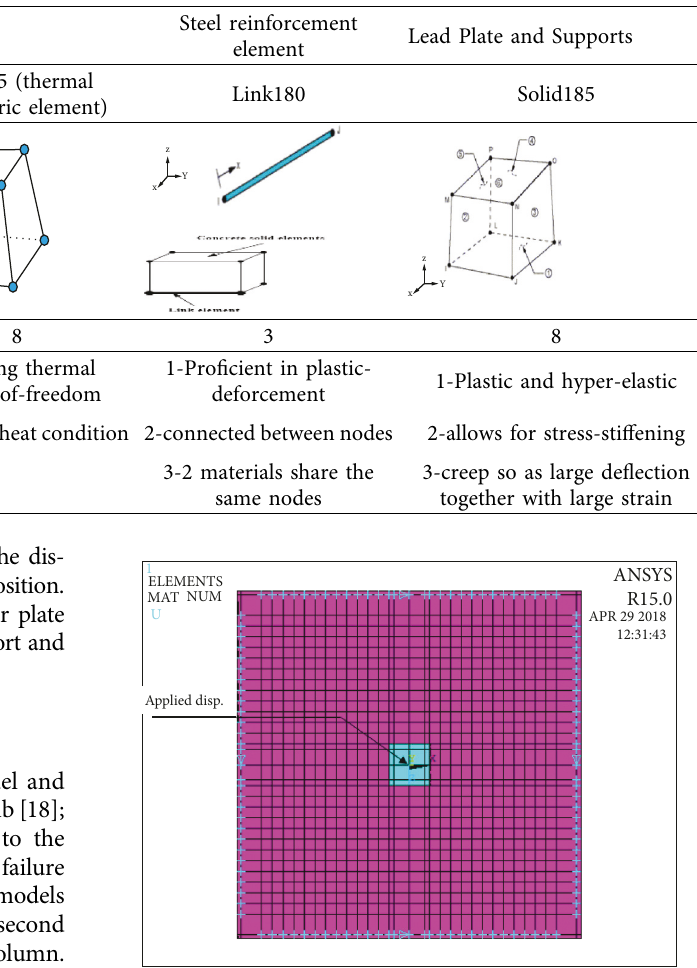
Figure 3: Support condition and applied